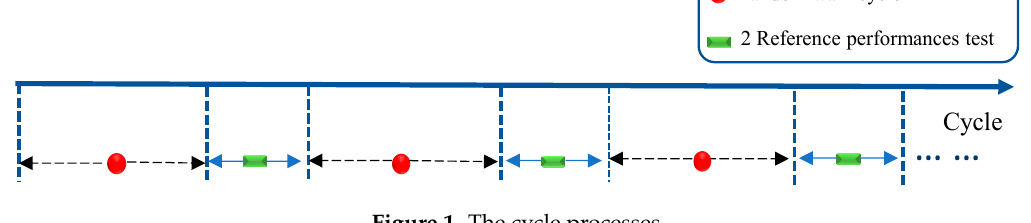
Figure 1. The cycle processes.